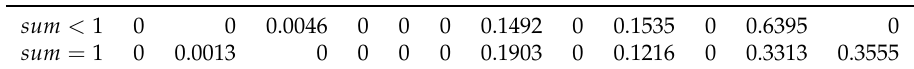
Table 7. First 12 coefficients α 2 of the survival functions for the cases sum < 1 and sum = 1 (the k remaining coefficients are 0).